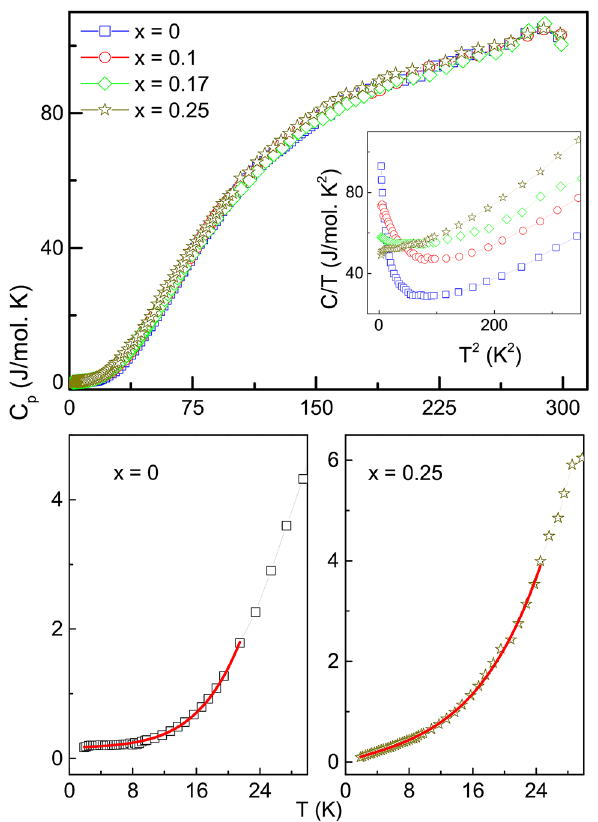
Cr x x Sn series. Inset −